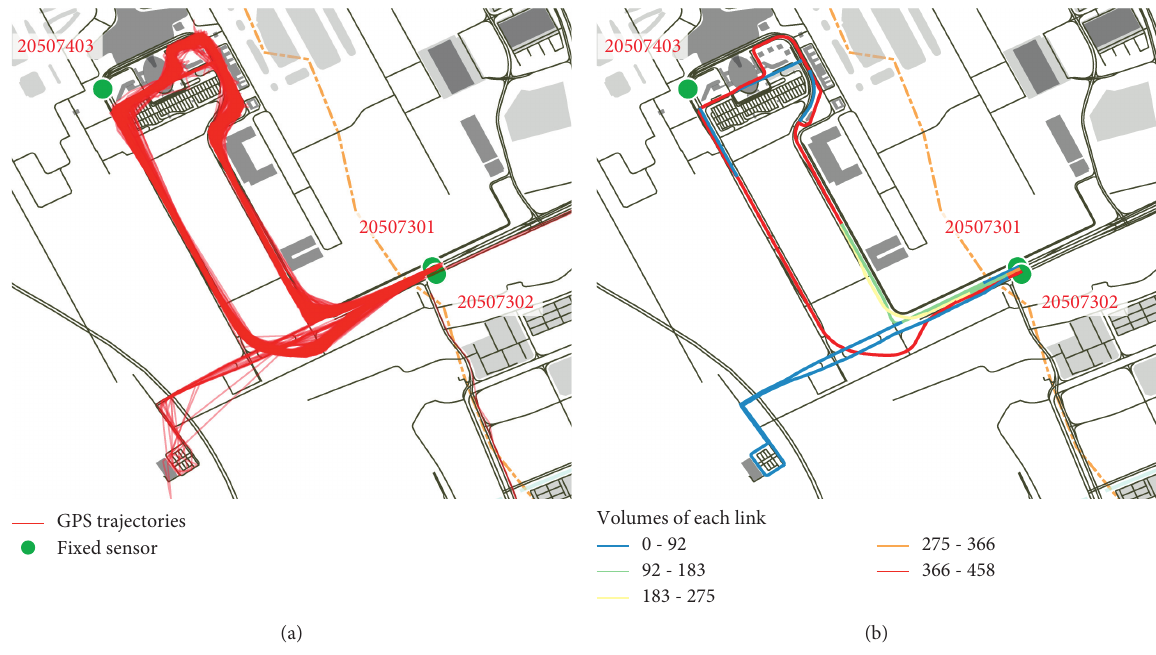
Figure 7: Example of realistic path generation. (a) GPS trajectories. (b) Volumes of each